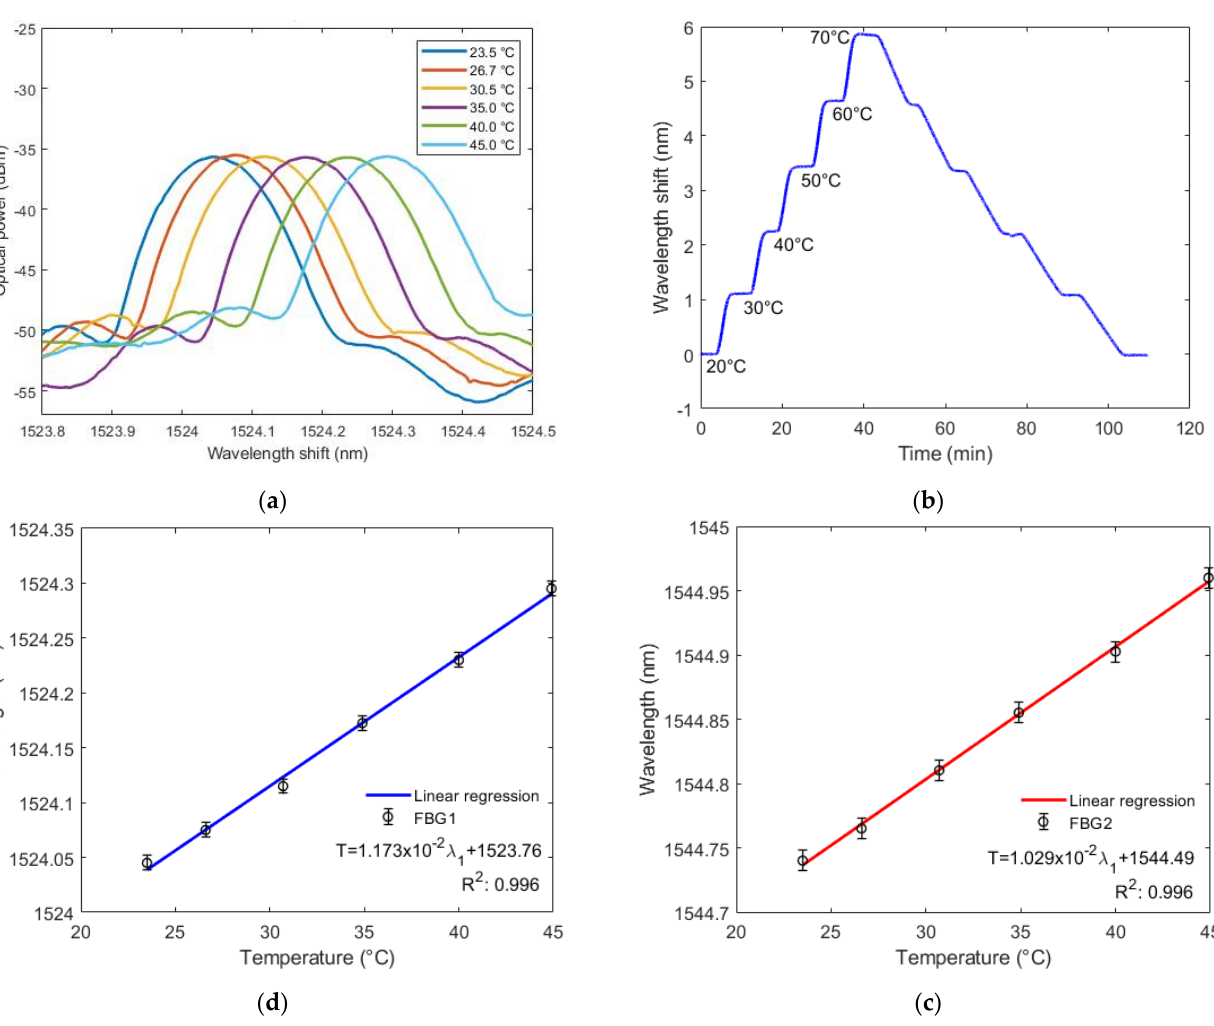
Figure 4. ( a – c ) Bragg wavelength shift as a function of the temperature for FBG1; ( d ) Bragg wave- length shift as a function of the temperature for FBG2.